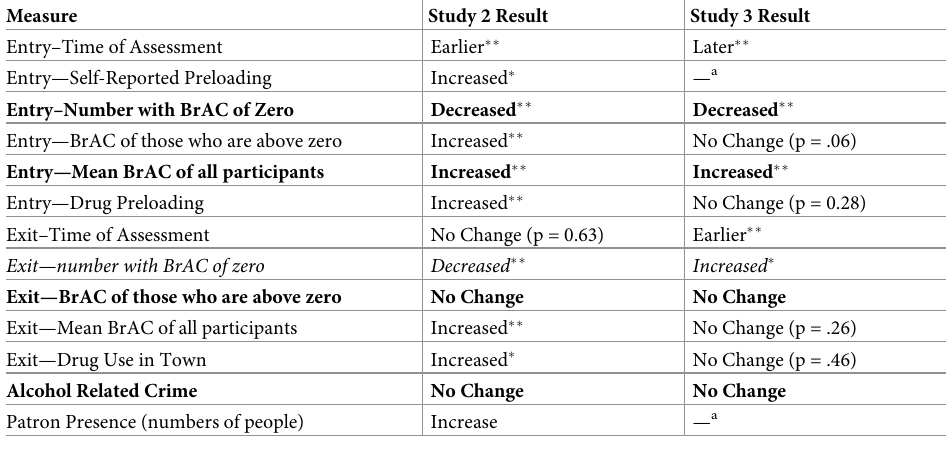
Table 9. Summary table of results for studies 2 and